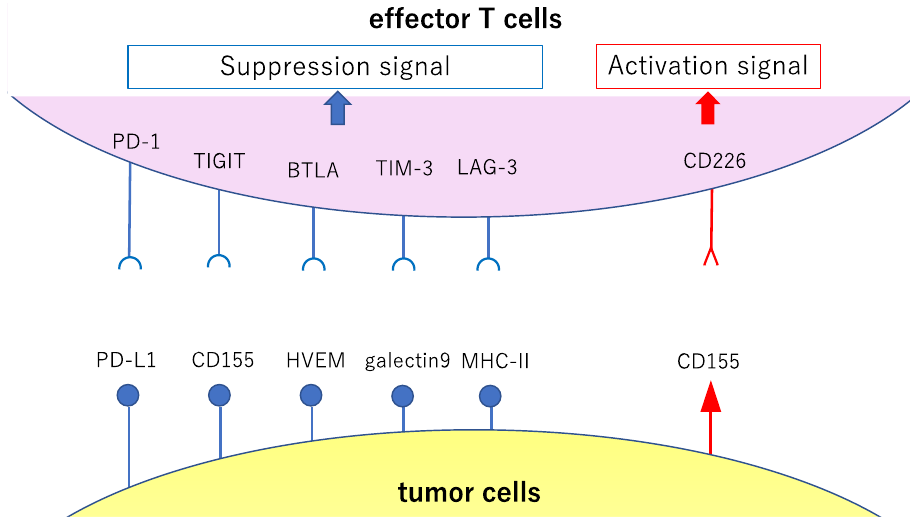
Figure 2. Major co-stimulatory and co-suppression molecules involved in the priming phase of cancer immunity. The cancer antigen presented by antigen-presenting cells in the lymph nodes is recognized via the T cell antigen receptor (TCR) by cancer-specific T cells (signal 1, main signal). Major co-stimulatory and co-suppression molecules producing auxiliary stimuli (signal 2, sub-signal) during this step and their ligands are shown here. The signals reinforcing the immune responses to cancer are shown in red, while those the attenuation of these responses are shown in blue.